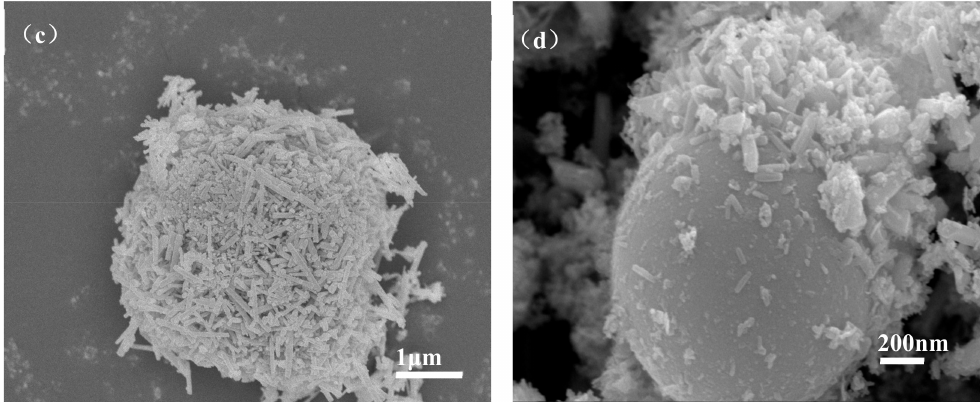
Figure 6. SEM images of ZCFA powder under di ff erent reaction temperatures: ( a ) 60 ◦ C; ( b ) 70 ◦ C; ( c ) 80 ◦ C; ( d ) 90 ◦ C.